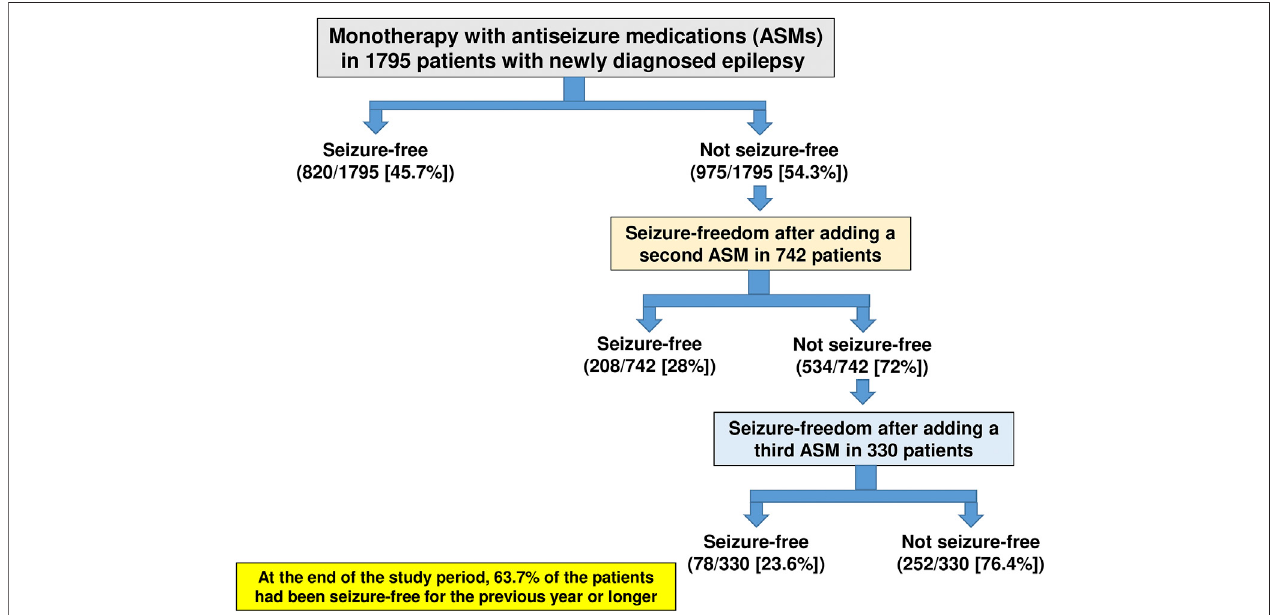
FIGURE 5 | Long-term treatment outcome in patients with newly diagnosed and treated epilepsy. Data are from a longitudinal observational cohort study conducted at the Epilepsy Unit of the Western In fi rmary in Glasgow, Scotland, over a period of 30 years. For details, see Chen et al. (2018).